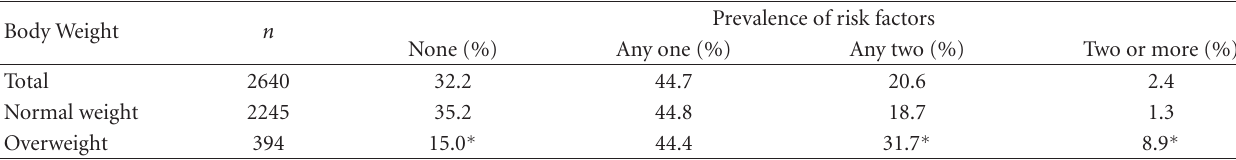
Table 2: E ff ects of body weight on prevalence and clustering of cardiovascular risk factors in teenagers in India. The risk factors considered were: blood pressure, fasting plasma glucose, HDL-cholesterol, triglycerides and waist circumference [46].